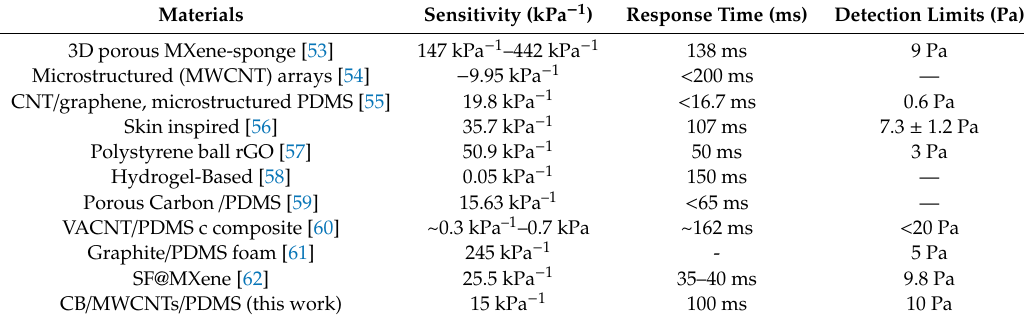
Figure 6. Durability and long-term stability of the 3D porous piezoresistive tactile sensor; The relative resistance change over 1000 cycles under continuously loading-unloading cycling and several magnified waveforms. Table 1. Key performance parameters of our work and recently reported flexible piezoresistive sensors.